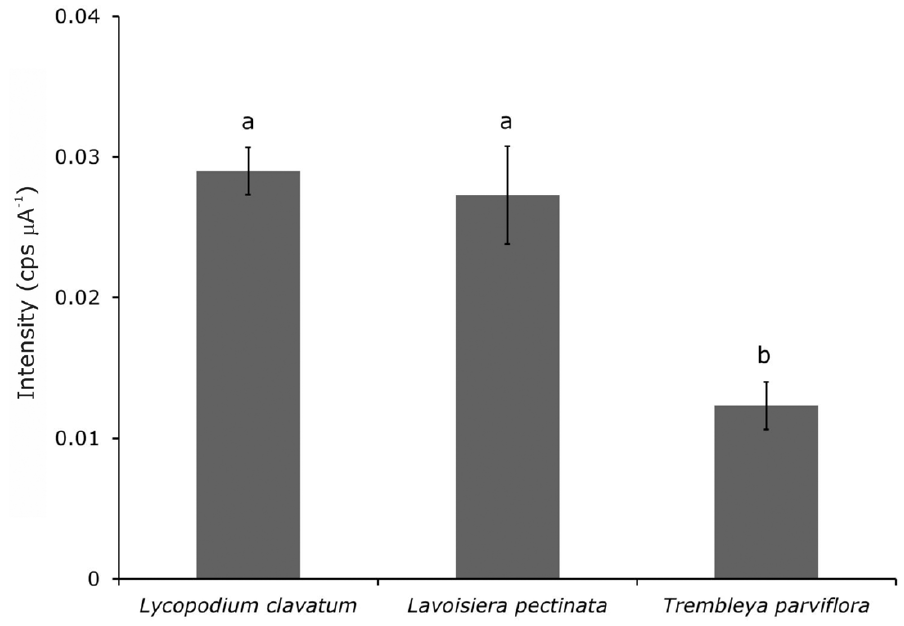
Figure 2 - Micro-energy dispersive X-ray spectrometry data of three different plant species in pellet formats (F = 14.323; p < 0.0001). Different letters represent significant differences of detected 2,27